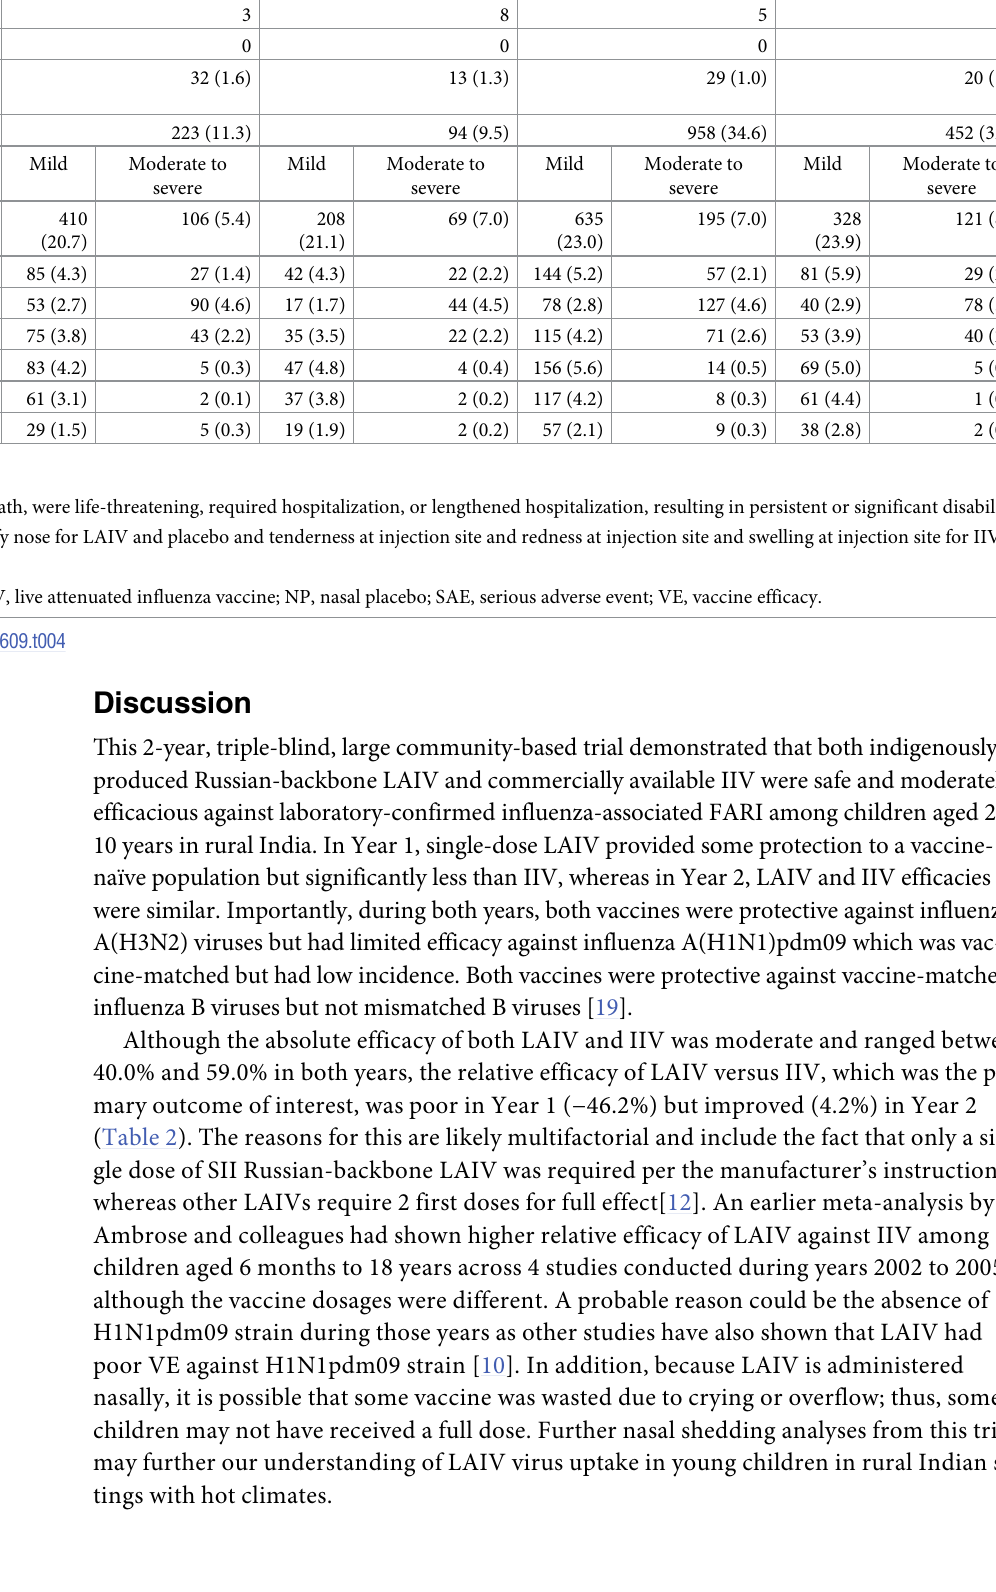
Table 4. Adverse events associated with live attenuated and inactivated influenza vaccines within 42 days post-administration, aggregated across study years. Adverse